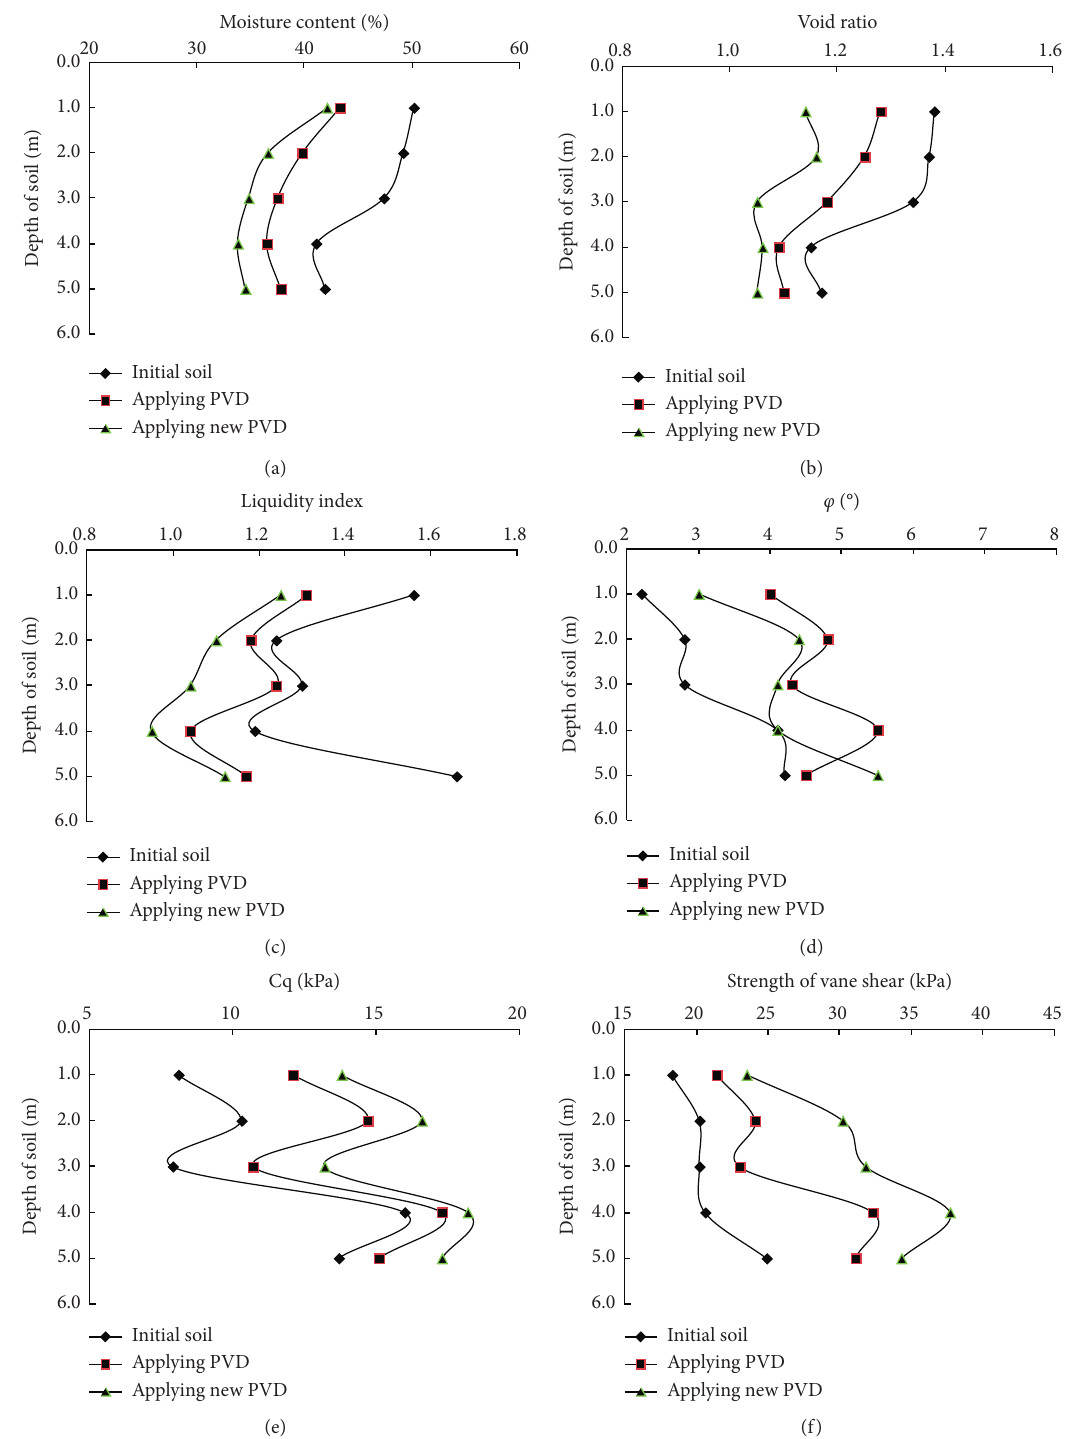
Figure 8: Basic physical and mechanical properties with depth: (a) soil moisture content with depth; (b) soil void ratio with depth; (c) soil liquidity index with depth; (d) φ with depth; (e) Cq with depth; (f) strength of vane shear with depth (before and after reinforcement with common and new